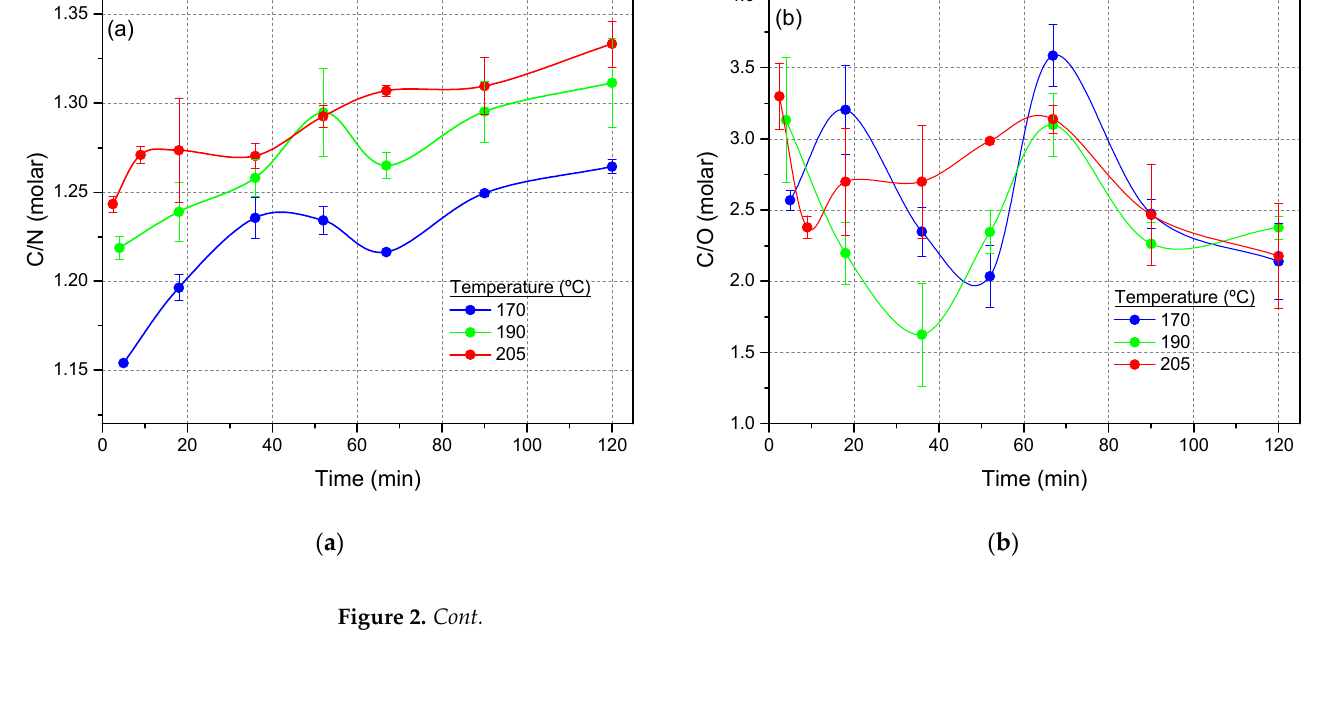
( d ) Figure 2. Evolution of the molar relationships for the three series of experiments carried out using MWR against reaction time (for details, please see Table S2). ( a ) C/N molar relationships; ( b ) C/O molar relationships; ( c ) C/H molar relationships and ( d ) N/O molar relationships. These molar rela- tionships represent the average values of three independent samples for each reaction condition. Similar results are observed when structural data are considered. The EOR (%) (Fig- ure 1, pink lines) was calculated from the intensities of some FTIR spectroscopic features, as follows: EOR (%) = [I 1640 /(I 2200 + I 1640 )] × 100, considering the study of conventional nitrile polymers [53]. The peak centered at ~1640 cm − 1 can be assigned to conjugated C=C, to